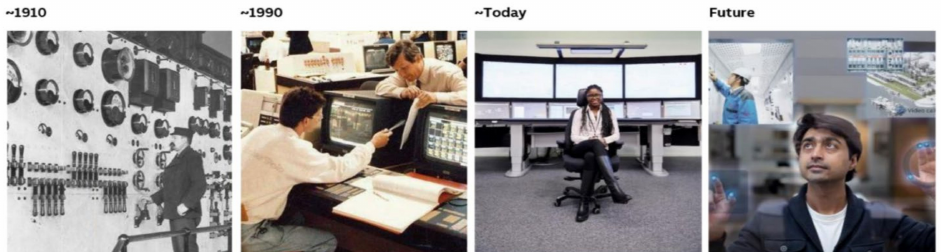
Figure 1. Operator Environments—An increasing amount of presented data have reached complexity beyond human